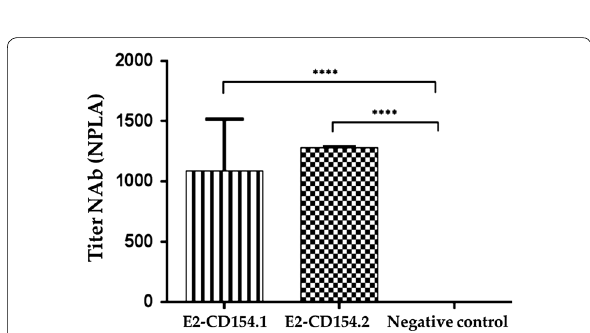
Fig. 5 Antibody titers measured by NPLA 7 days after booster in the immunization experiment in mice. Data are expressed as the reciprocal of the average of antibody titers in each group. Neutralizing antibodies (NAb) were measured by the serum ability of each animal to neutralize 100 TCID50 of CSFV produced in 500 PK‑15 cells. Asterisks represent statistical significant differences (p < 0.0001, Tukey’s multiple comparisons test). Standard deviations are